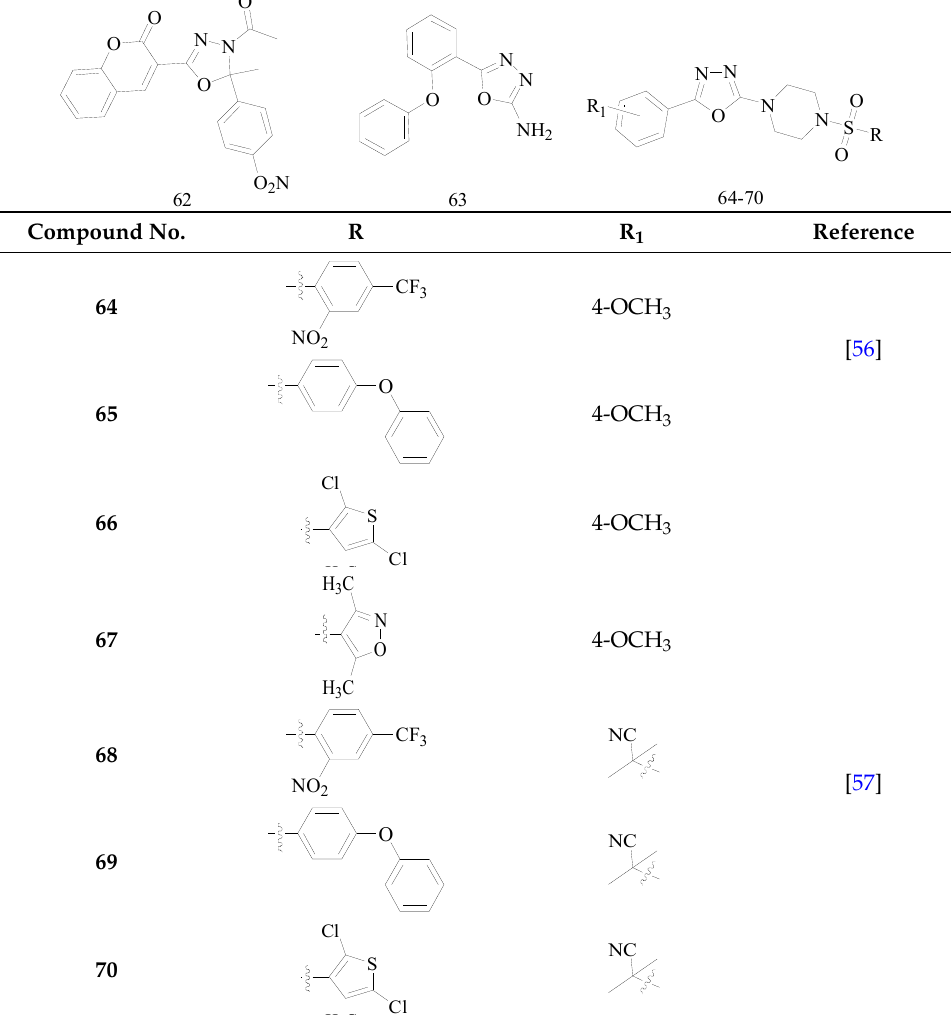
Table 4. Anticonvulsant oxadiazole or benzoxazinone compounds.